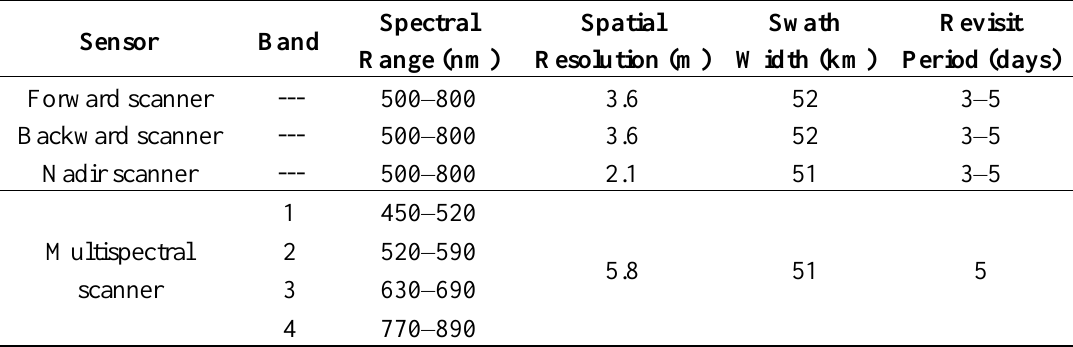
Table 3. Primary characteristics of ZY-3.